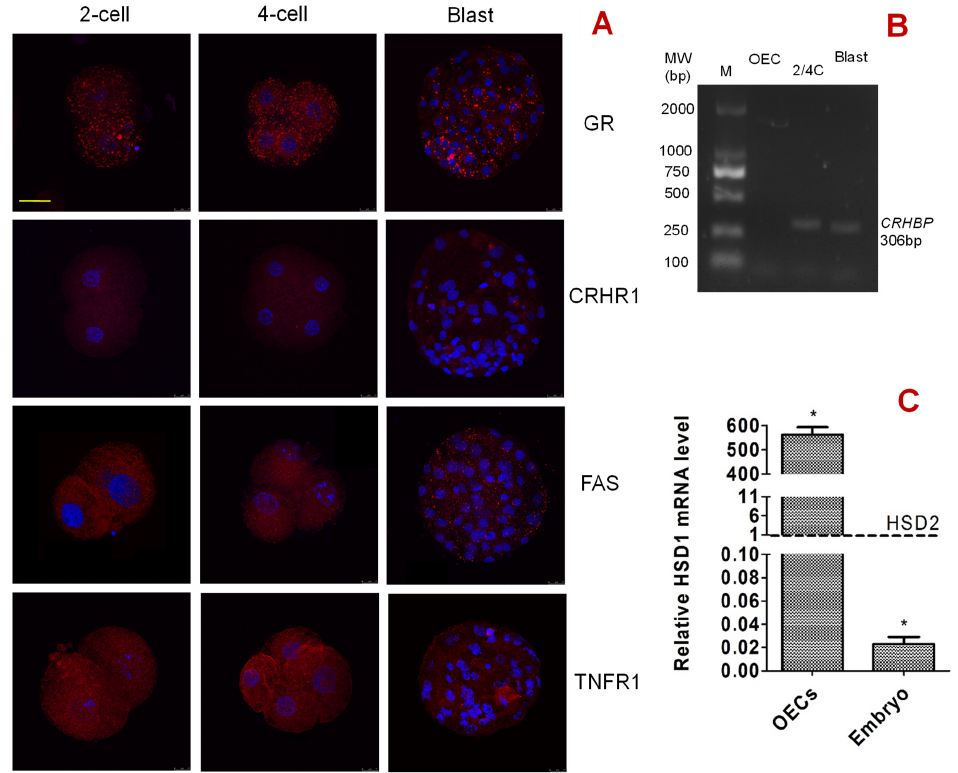
Figure 7. Expression of corticotrophin-releasing hormone receptor (CRHR1), glucocorticoid receptor (GR), FAS, tumor necrosis factor receptor (TNFR1), corticotrophin-releasing hormone-binding protein (CRHBP) and hydroxysteroid 11-beta dehydrogenase 1/2 (HSD11B1/HSD11B2) in pig pre- implantation embryos. Panel ( A ) shows expression of CRHR1, GR, FAS, and TNFR1 in 2-cell, 4-cell and blastocyst (Blast) embryos, as revealed by immunofluorescence microscopy. The micrographs are merged images from laser confocal microscopy with target proteins and DNA colored red and blue, respectively. The bar is 50 µm and applies to all images. While 2-cell and 4-cell embryos were observed at 48 h, the blastocysts were observed on day 6 after the onset of embryo culture. Panel ( B ) shows mRNA expression of CRHBP in pig oviduct epithelial cells (OECs), 2- or 4-cell embryos (2/4C) and blastocysts (Blast), as revealed by a general PCR amplification. The annealing temperature for the general PCR amplification was set to 58 ◦ C. M: DM 2000 DNA marker. The molecular weight for CRHBP mRNA is 306 bp. Graph ( C ) shows relative levels of HSD11B1 (HSD1) and HSD11B2 (HSD2) mRNAs in pig embryos and OECs. The level of HSD11B2 mRNA was set as one (dotted line), and the level of HSD11B1 mRNA was expressed relative to it. * Indicates significant difference from the value of HSD11B2